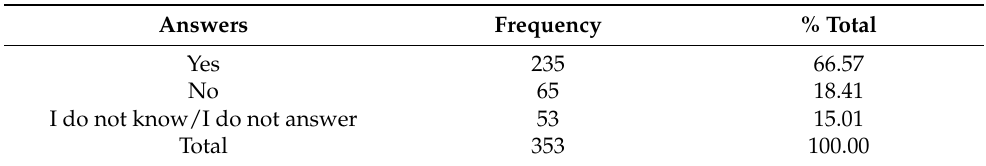
Table 8. Results for the attitude of the believers about the action of the Holy Synod to dismiss the Prime Minister and the Minister of